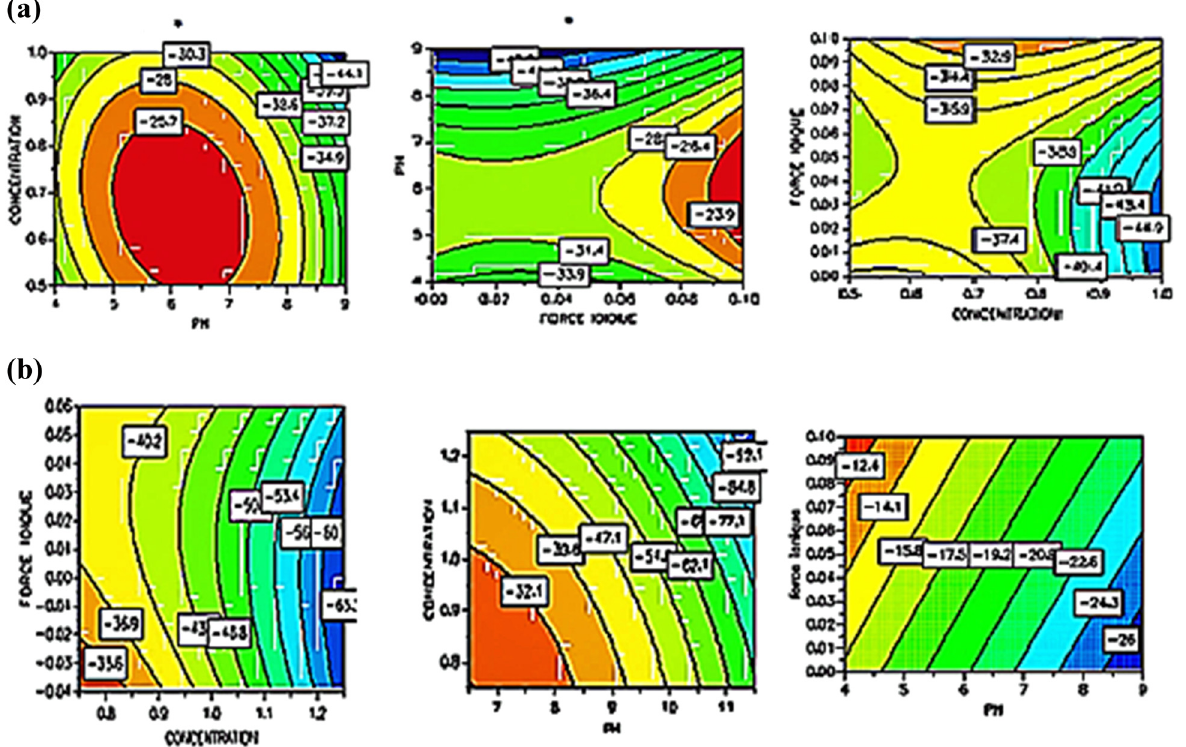
Figure 8: Surface plots showing the interaction e ff ects of ( a ) concentrations of pectin ( w% ) and pH and ( b ) ionic strength and pH on ζ - potential of pectin extracted from